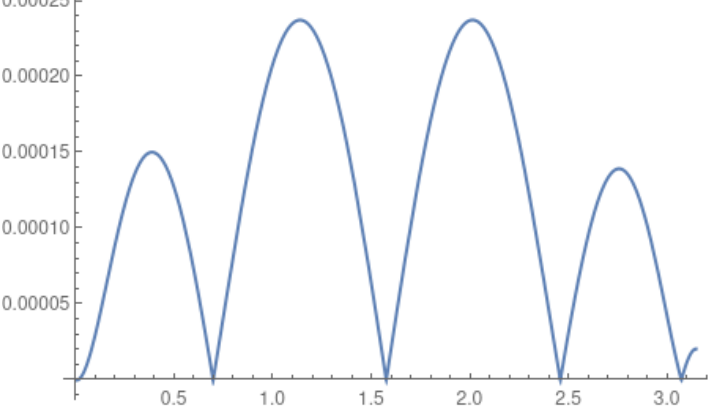
Figure 1. The absolute error of the 5th degree approximation by PLSM for problem